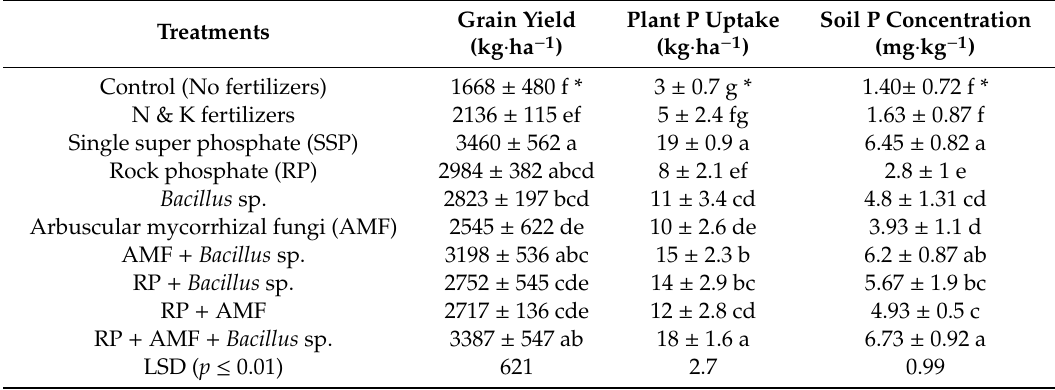
Table 1. Maize grain yield and post-harvest soil and plant P concentration as influenced by the inoculation of AMF and PSB strain ( Bacillus sp. PIS7) with RP. Grain Yield Plant P Uptake Treatments (kg · ha − 1 )